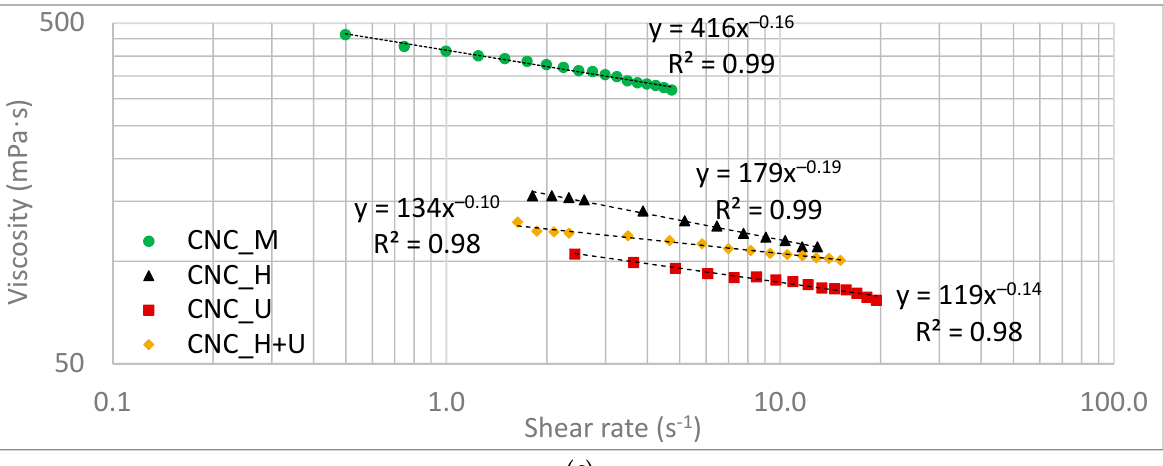
Figure 1. Viscosity measurement results of the CNC suspensions treated by different methods ( a ) torque versus RPM, ( b ) viscosity versus shear stress, and ( c ) viscosity versus shear rate.